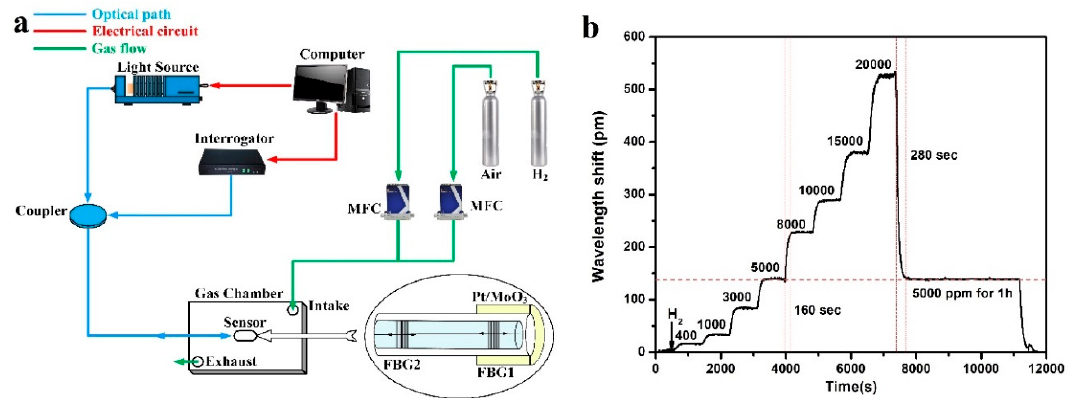
Figure 1. ( a ) Configuration of fiber Bragg grating (FBG) hydrogen sensing system. ( b ) Hydrogen response of Pt/MoO 3 .